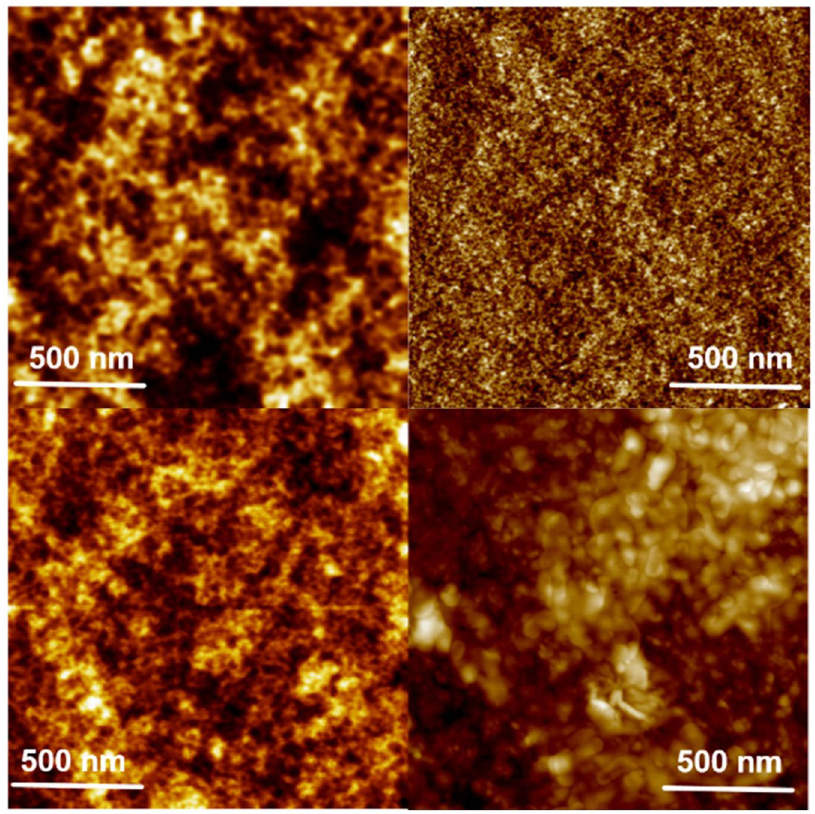
Figure 4. AFM topographic images of DHI thin films with thickness of 0.2 μ m (upper row) and 0.5 μ m (lower row) as prepared (left column) and after SSSP over 4 weeks (right